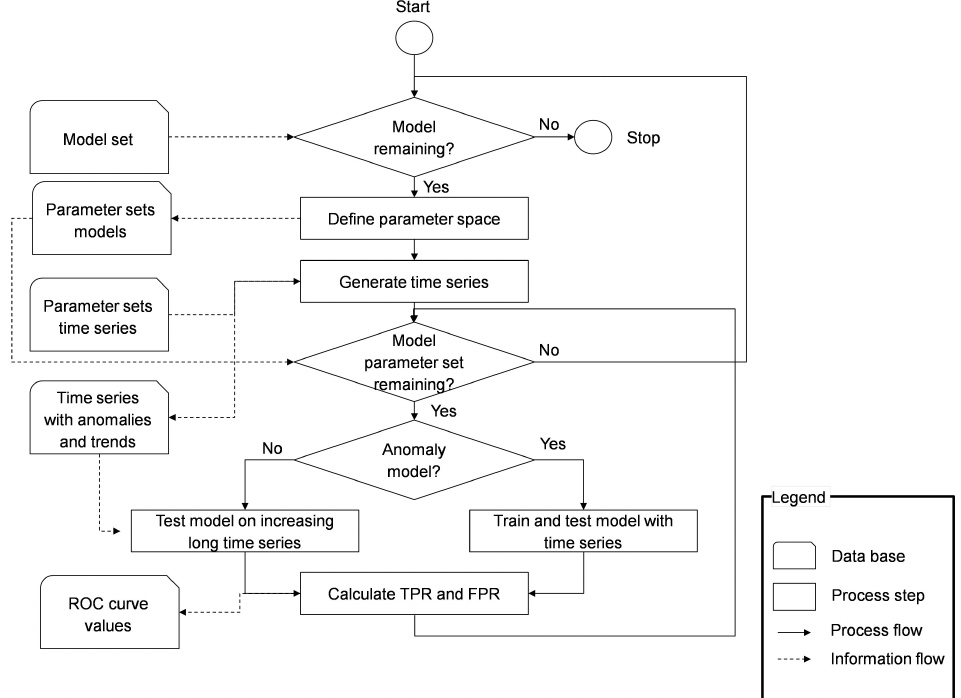
Figure 6. Overview of the model evaluation